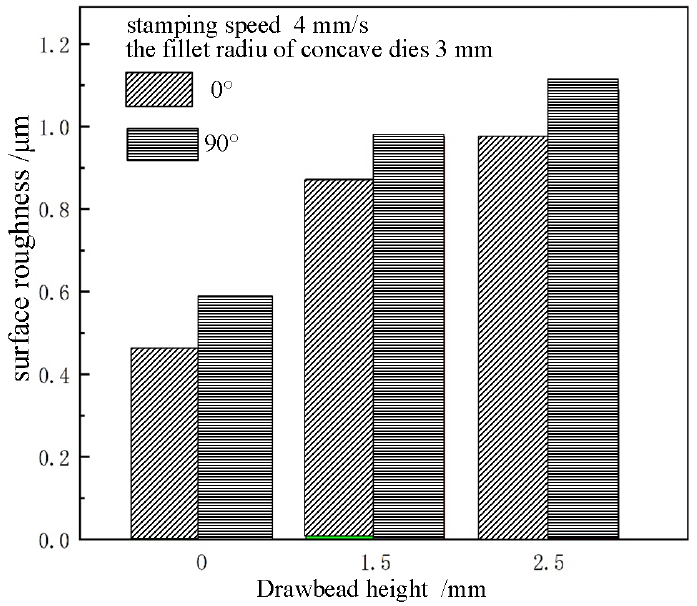
Figure 11. Influence of rolling direction on the surface roughness of the specimen.